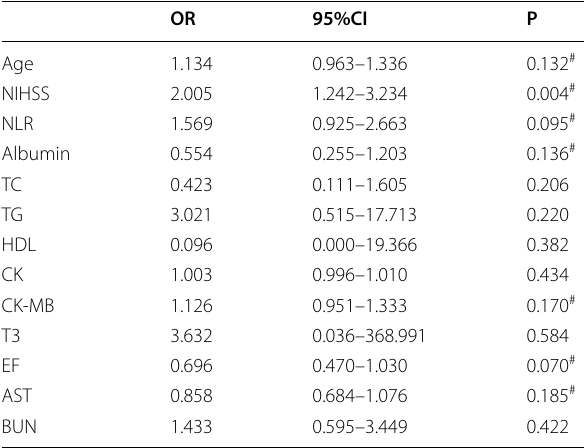
CK creatine kinase, CK-MB creatine kinase-MB, LVDD left ventricular diastolic diameter; LVSD left ventricular systolic diameter; LAD left atrial diameter, LVWT left ventricular septal thickness, EF ejection fraction, *p < 0.05 Table 3 Multivariate logistic regression according to the functional